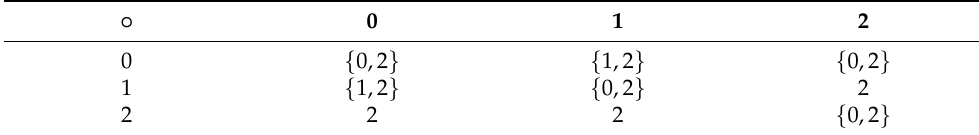
Table 17. QM-quasi-hyper BZ